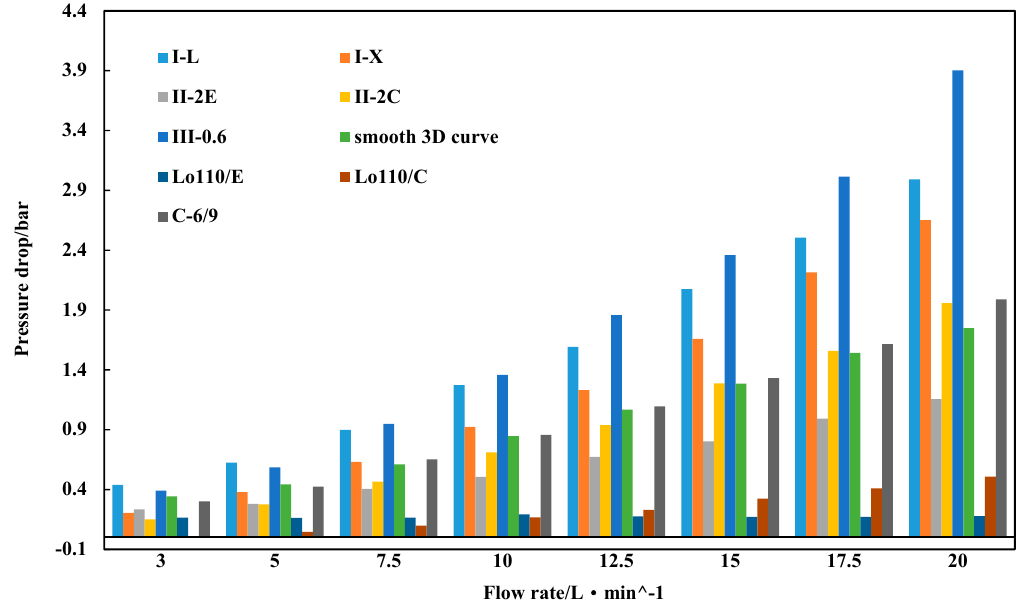
Figure 22. Comparison of pressure drop in traditional and novel channels.